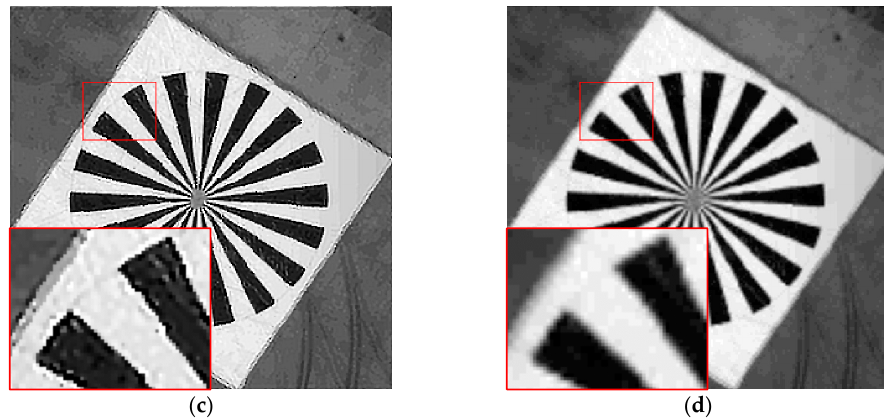
Figure 11. Simulation results of experiments with the three methods. The images enclosed in red box are the details of the three different algorithms. ( a ) Original image; ( b ) image based on the proposed algorithm; ( c ) image based on the blind SR reconstruction algorithm; and ( d ) image based on the bicubic interpolation algorithm.